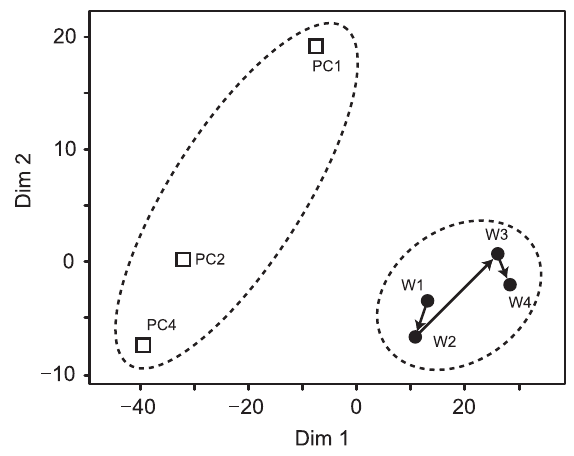
Figure 7. Multidimensional scale plot comparing bacterial communities based on genus level taxonomy. Open square, the bacterial communities of original primary clarifier effluents (PC1, PC2, PC4); Filled circle, the bacterial communities of anode biofilm enriched in the primary clarifier effluent-fed MFC (W1–W4).